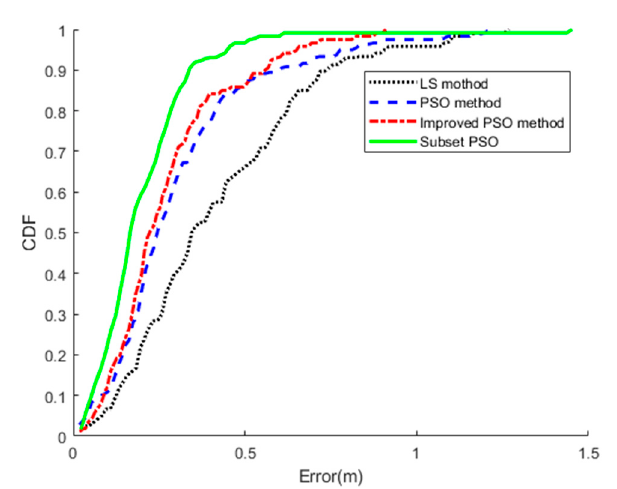
Figure 6. Comparison of the cumulative distribution function of the methods based on Particle Swarm